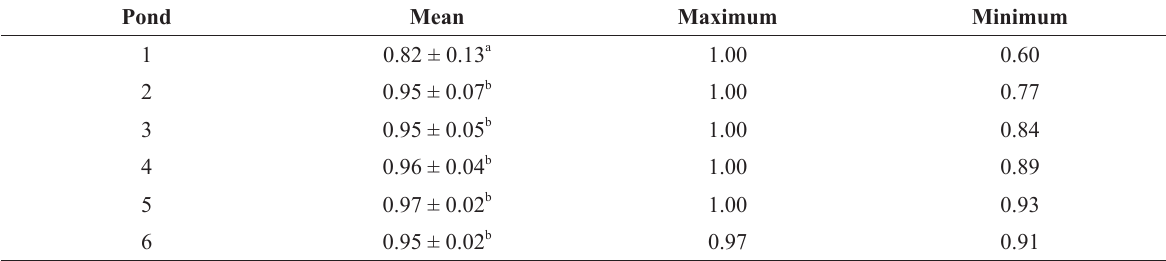
Means (± SD) of scalar efficiency in the ponds of the conventional system in a farm located on the coast of Pernambuco, Brazil.